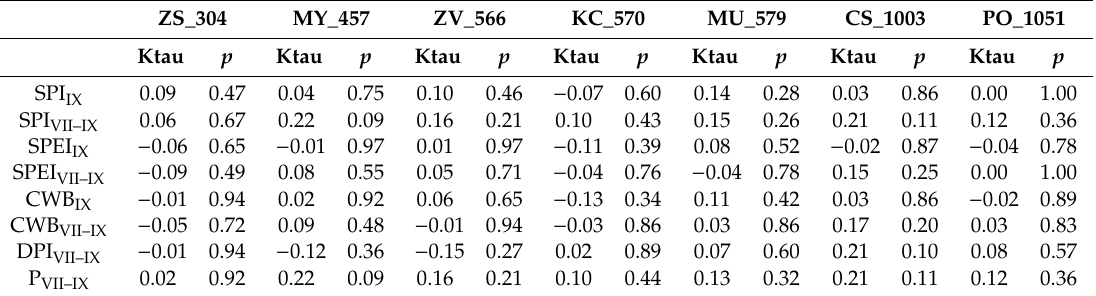
Table A1. Temporal trend of the meteorological drought indices and